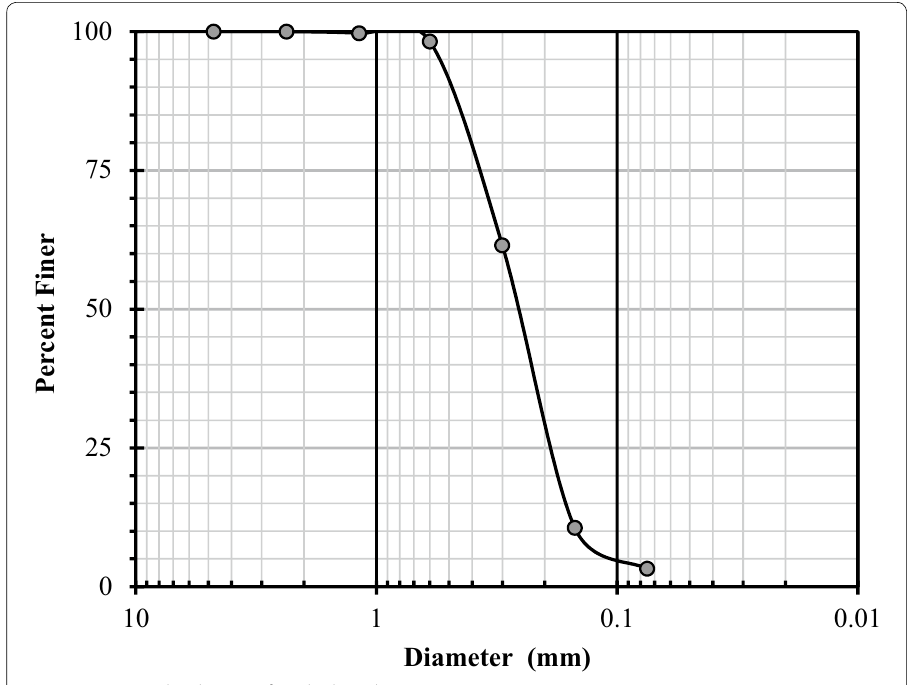
Fig. 1 Grain size distribution of studied